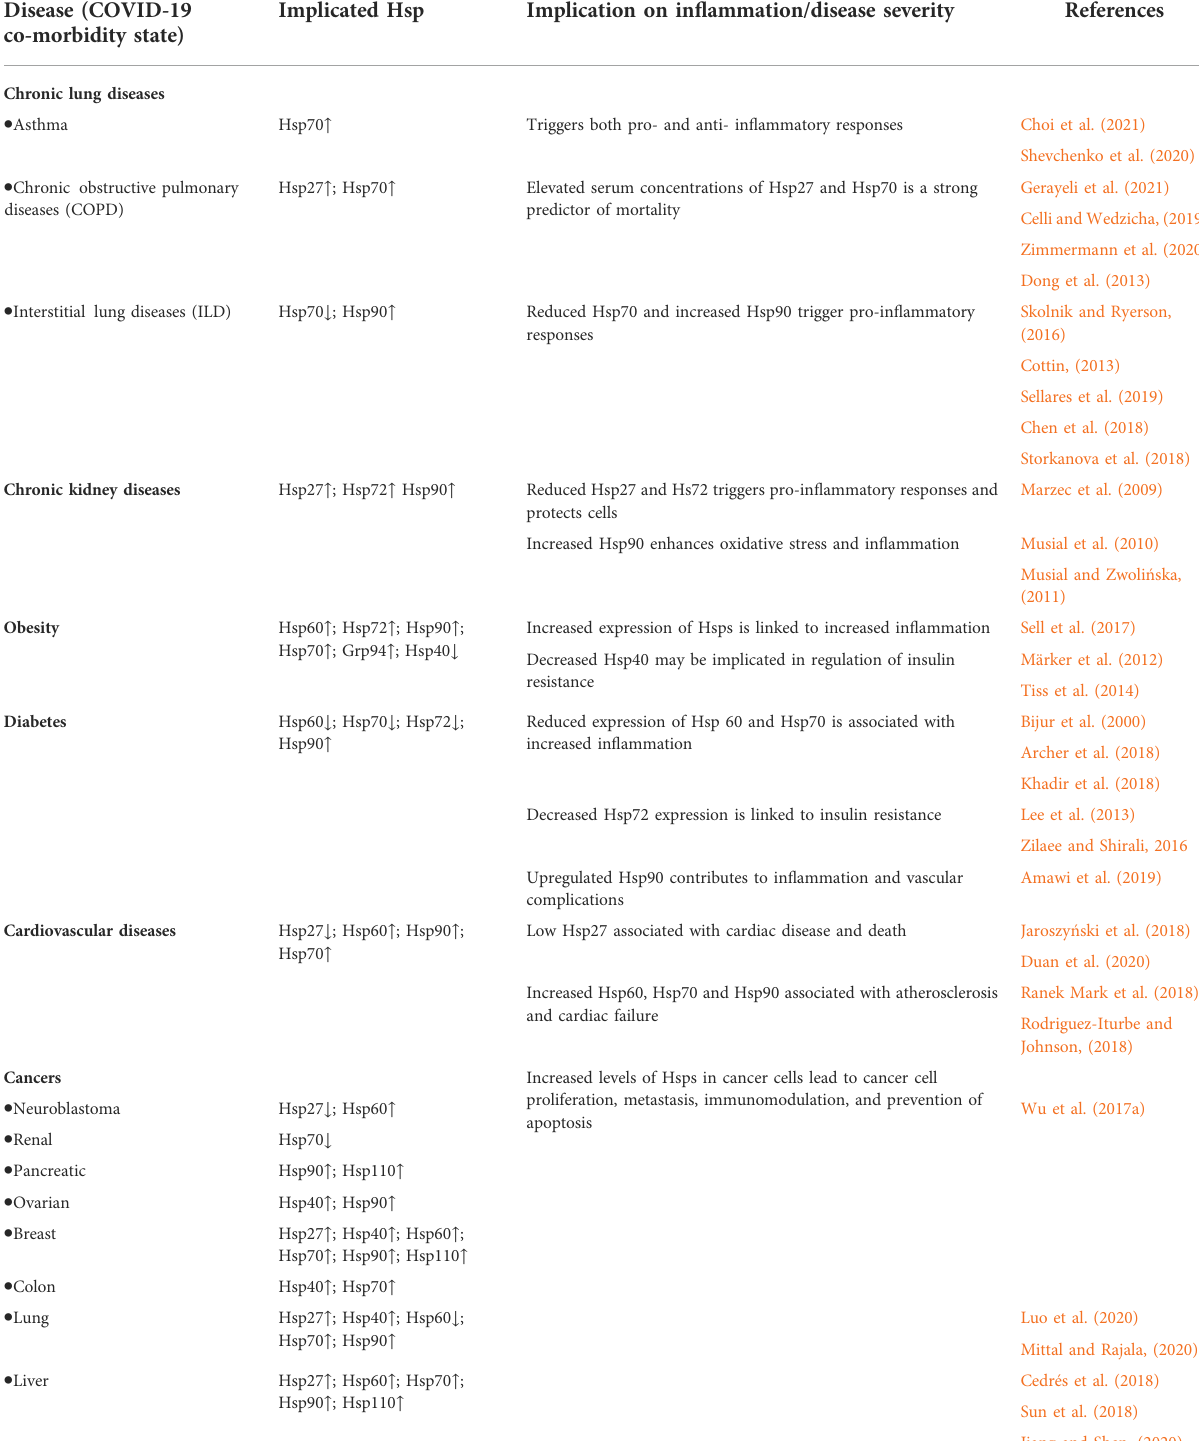
TABLE 1 The role of Hsp expression levels in